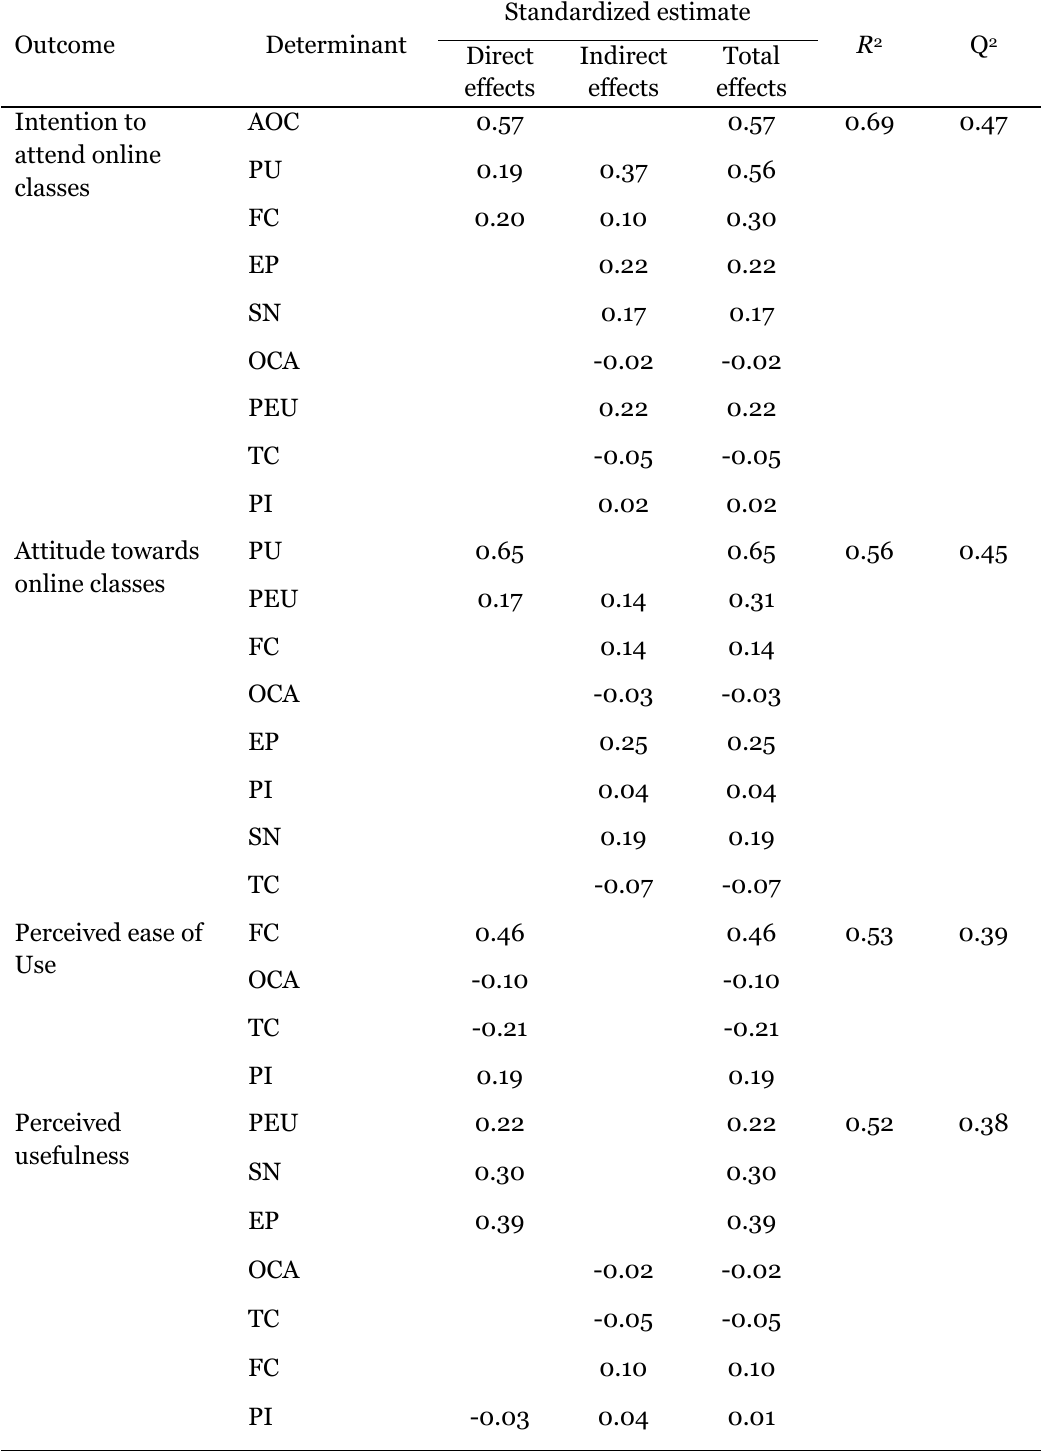
Table 5 Direct, Indirect, and Total Effects of the Research Model